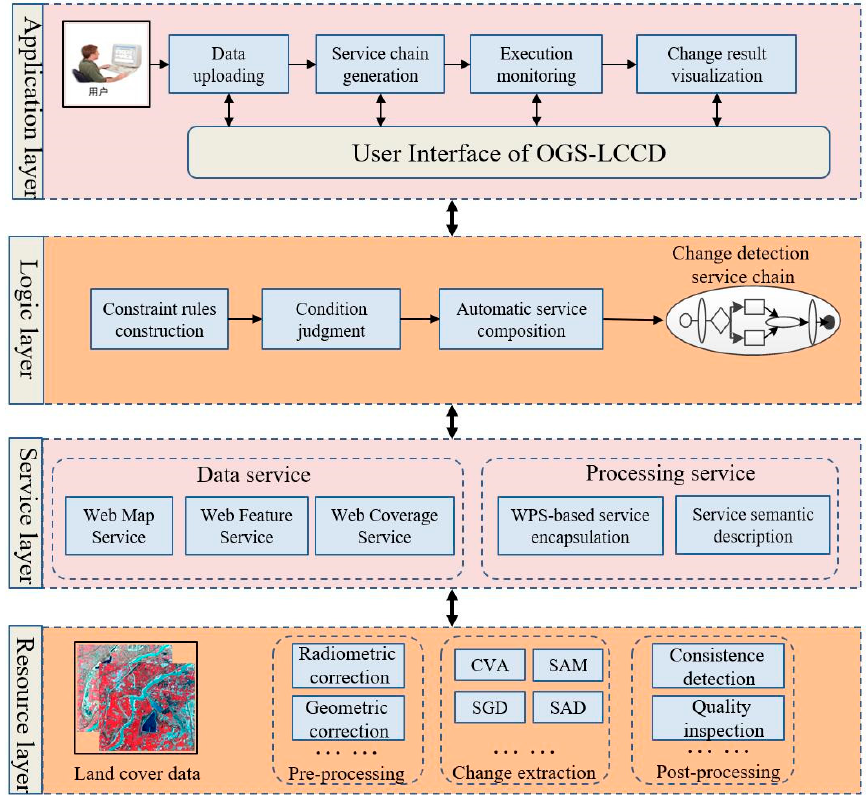
Figure 3. Online geoprocessing system for supporting intelligent land cover change detection (OGS-LCCD) architecture.